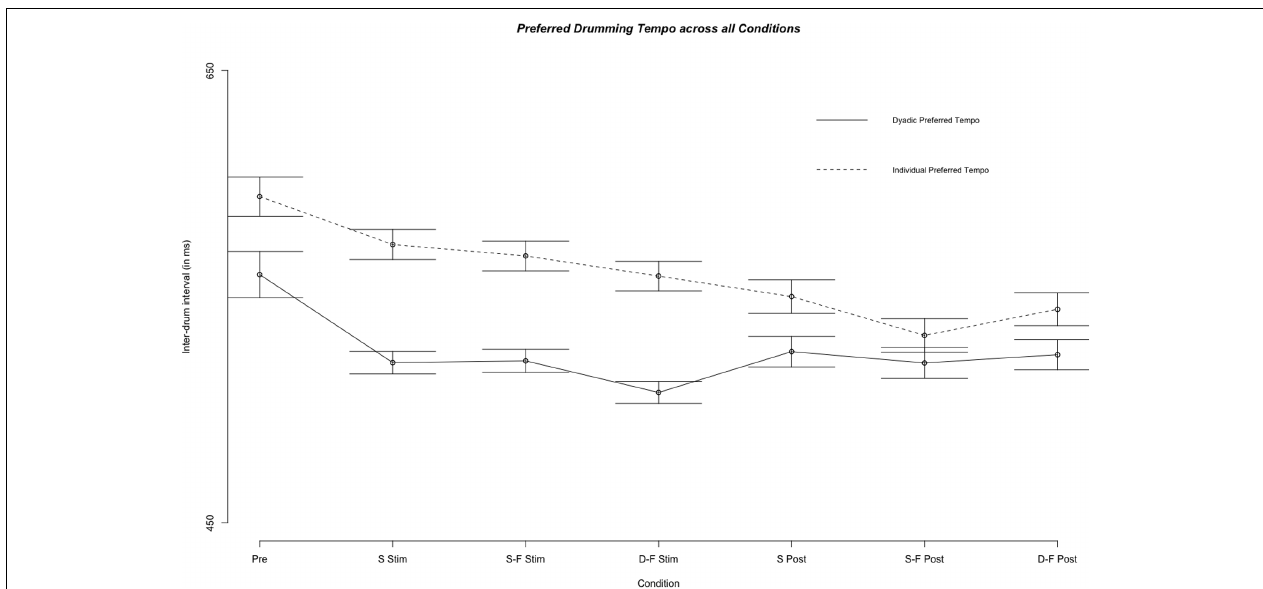
FIGURE 5 | Comparison of the fixed effect results of the linear mixed model analysis for the effect of condition on individual preferred and dyadic preferred drumming tempo for all experimental conditions. Displayed are mean inter-drum intervals as estimated by the model. Stimulation conditions: Pre, pre; S Stim, sham stimulation; S-F Stim, same-phase-same-frequency stimulation; D-F Stim, different-phase-different-frequency stimulation; S Post, sham post; S-F Post, same-phase-same-frequency post; D-F Post, different-phase-different-frequency post. Standard errors are indicated by horizontal